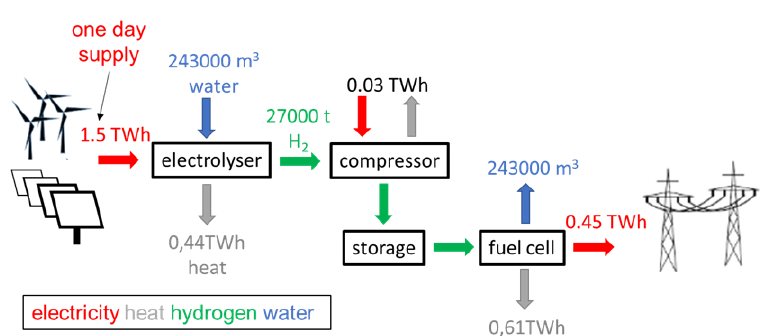
Fig. 8. – Schematic of a system to generate secondary electricity from primary iRE power using an electrolyser to produce hydrogen and a fuel cell to generate secondary electricity. The numbers exemplify the situation of one day of German electricity consumption of ∼ 1 . 5 TWh. Heat generation and water consumption are also given. The schematic follows